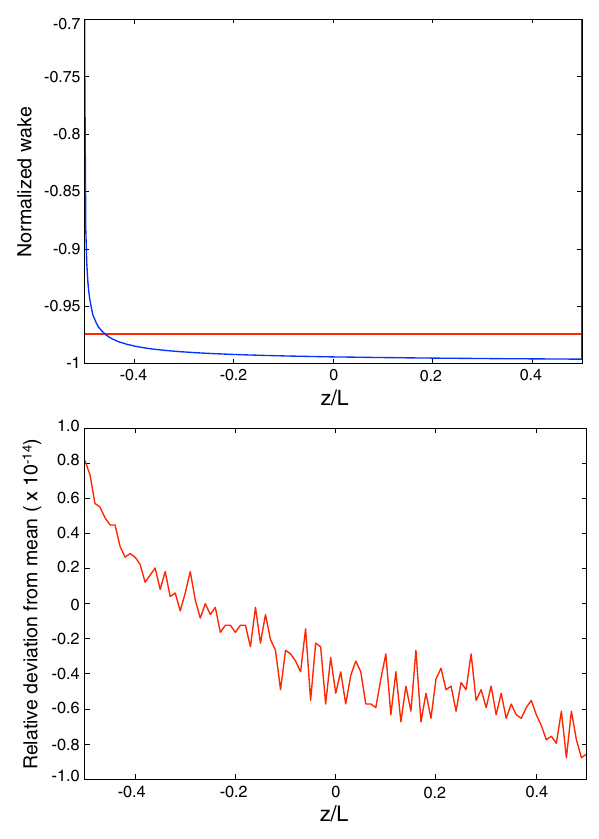
FIG. 3. The 1D CSR wakefield across the length of the bunch is shown as computed using (23) for the analytically determined density (15) (blue) and from the numerical solution of the system (25) (red). The wakefield is normalized by the quantity W 0 of (14). The lower figure illustrates the relative fluctuations in the value of the CSR wakefield as computed from the numerically determined solution.